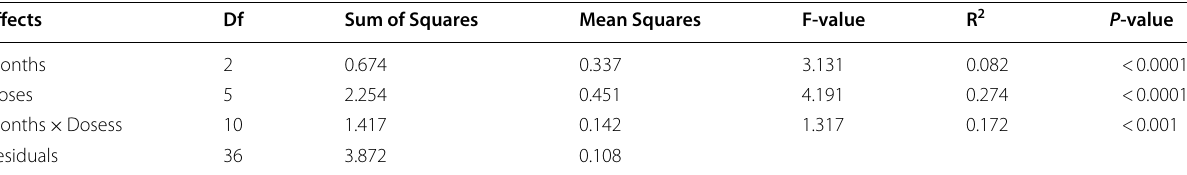
Table 1 Permanova of bacterial communities based on Bray–Curtis dissimilarities between non-amended and sclerotia-amended soil samples of rice-rapeseed rotation field soil amended with different doses of R. solani sclerotia